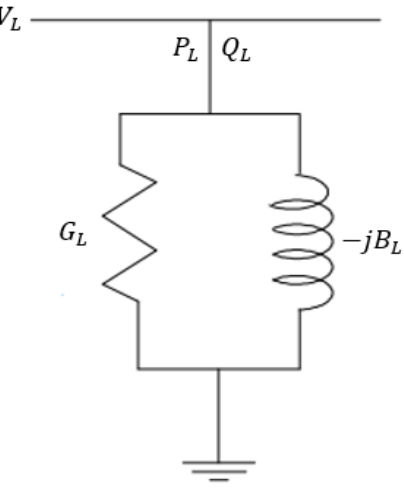
Figure 11. Modeled representation of load.